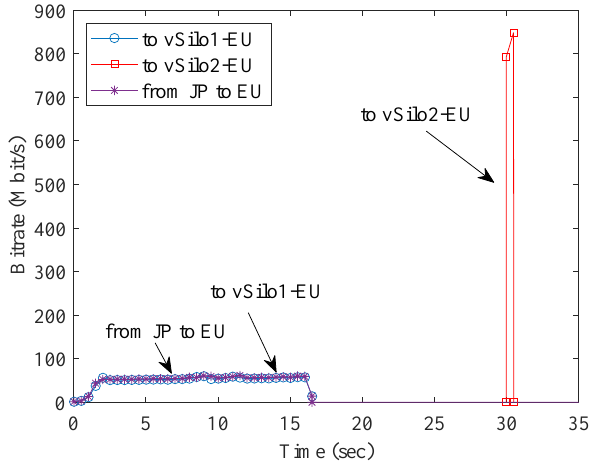
Figure 12. HTTP traffic during the download of a generic content.